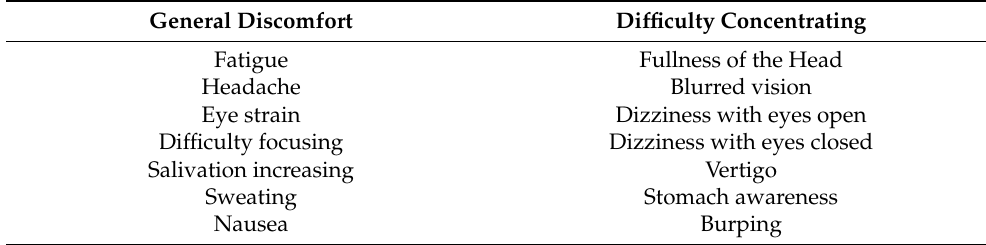
Table 2. Kennedy classification of symptoms